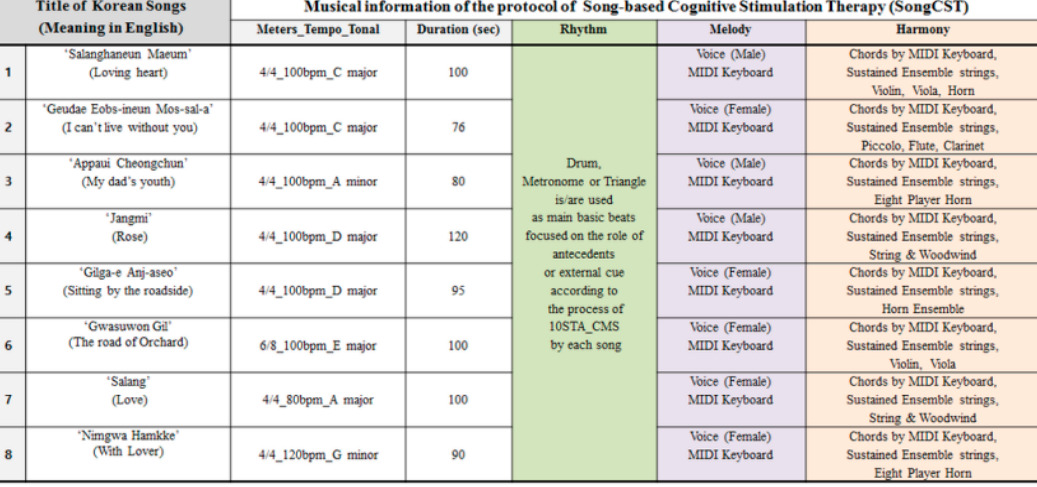
Figure 3. Musical information on eight songs. Musical information and components of each song, considering the therapeutic musical elements of acoustic, cognitive, and emotional function of elderly patients with MCI.